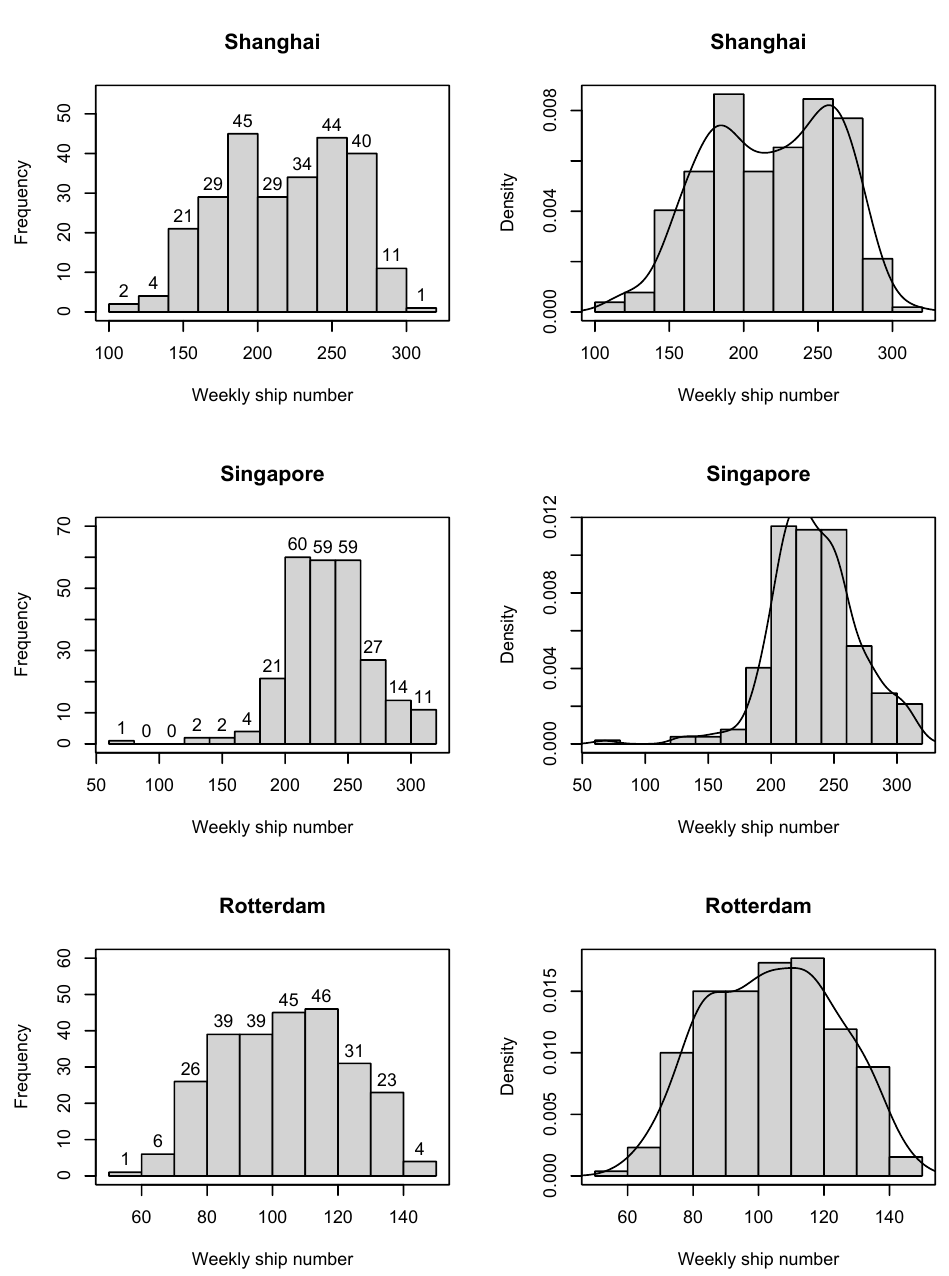
Figure 3. Frequency and probability density distribution of weekly ship flow